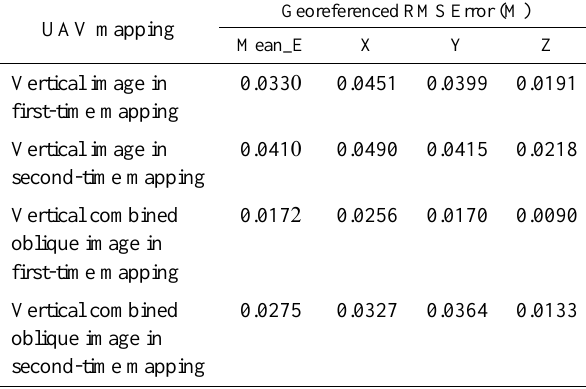
Table 5. Map accuracy of Quad-rotor